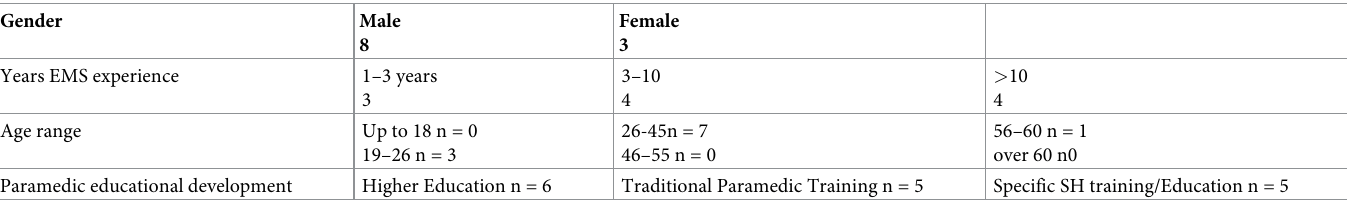
Category 1: Context. Paramedics described the importance of the context of the encoun- ter with people who SH at two phases in the process of care: pre-arrival, and on-scene care. The pre-arrival phase included contextual factors relating to the patient, such as the role of Table 1. Sample of study